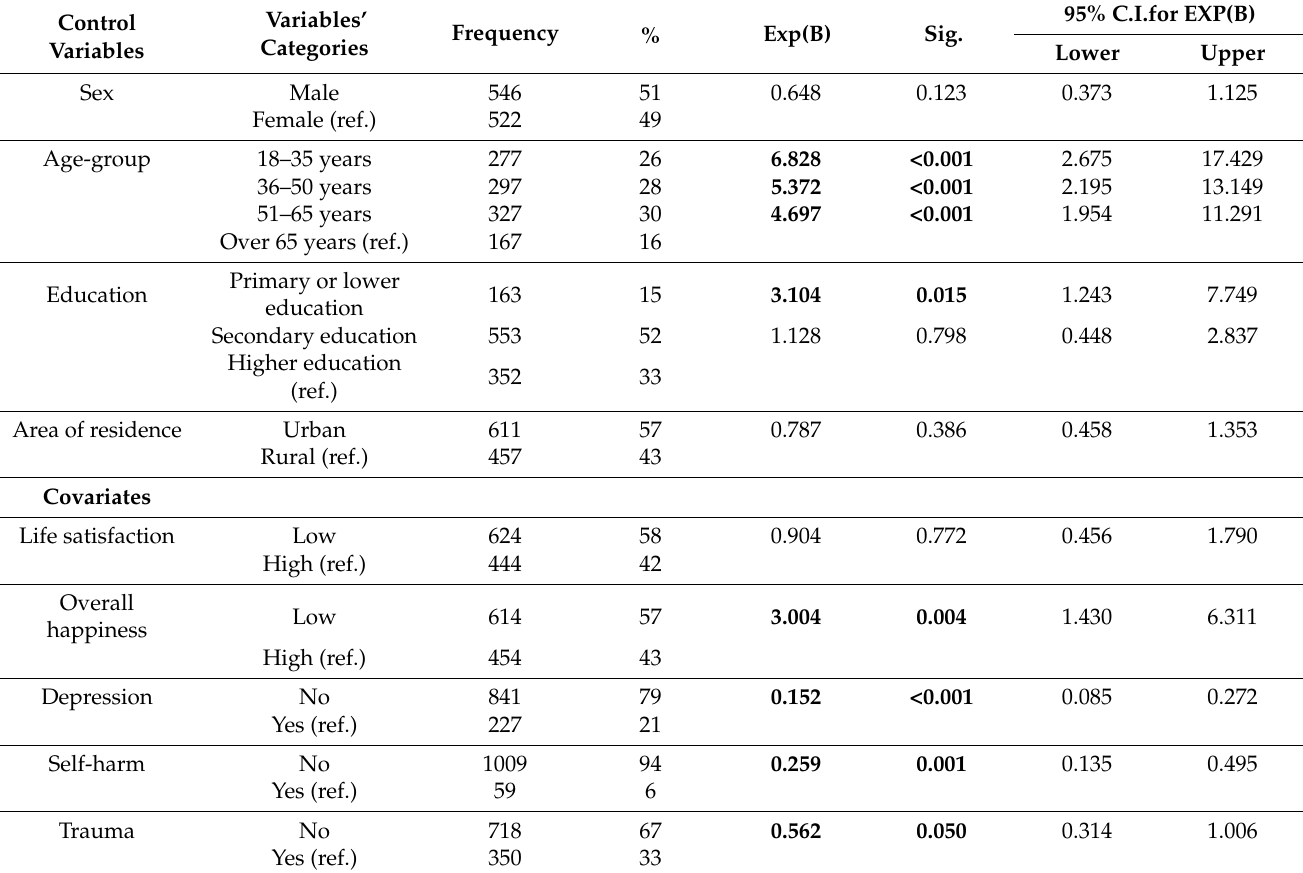
Table 4. The results of the logistic regression on the existence of suicidal